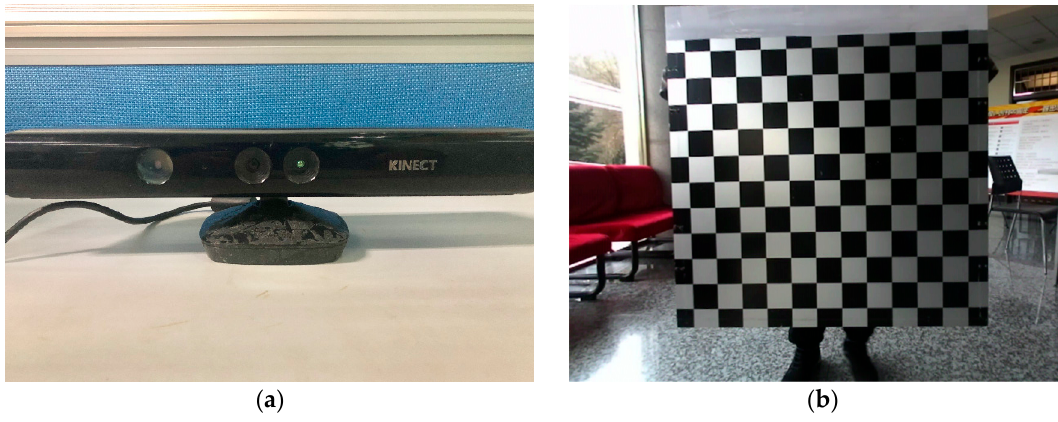
Figure 2. RGB-D camera and flat calibration board used in data acquisition and camera calibration. ( a ) Microsoft Kinect V1 sensor used in data acquisition; ( b ) flat calibration board used in camera calibration. Table 1. Internal parameters and distortion coefficients of the RGB camera and depth camera. Camera